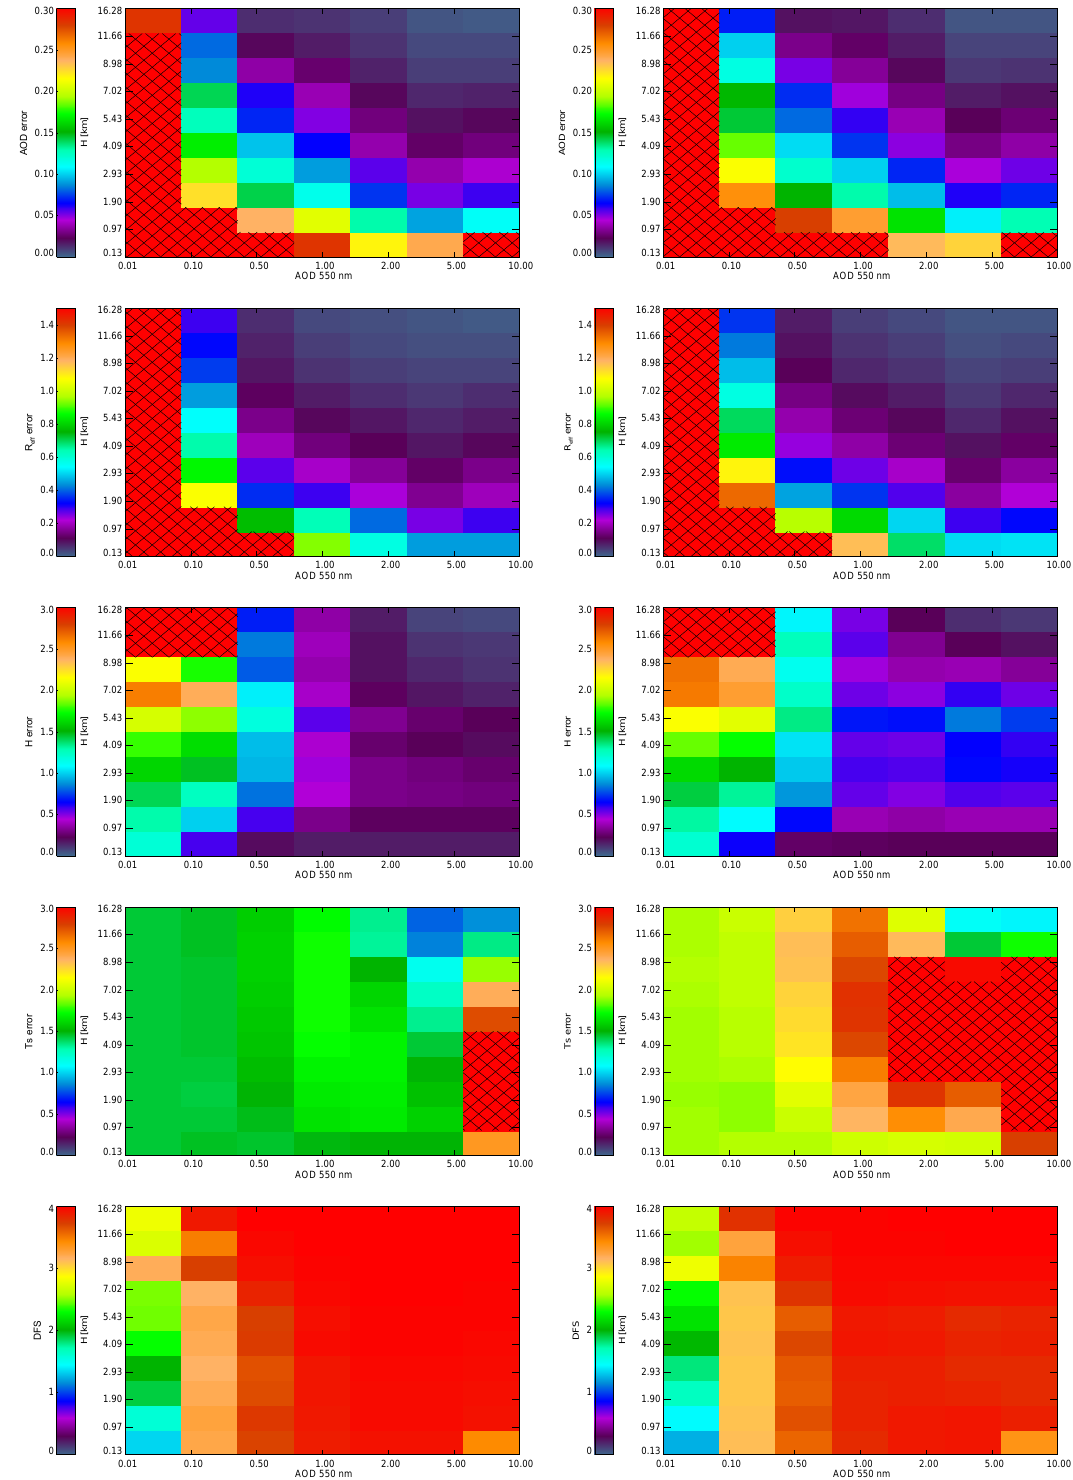
Figure 4. The uncertainties in the retrieved parameters and the DFS available in the retrieval using the clear (first column) and cloudy (second column) covariance matrices, shown as a function of ash optical depth (horizontally) and plume top altitude (vertically). From the top, the rows exhibit the uncertainties in ash optical depth, effective radius, plume top altitude, effective radiating temperature, and available DFS. Any value higher than the colour bar scale is shown